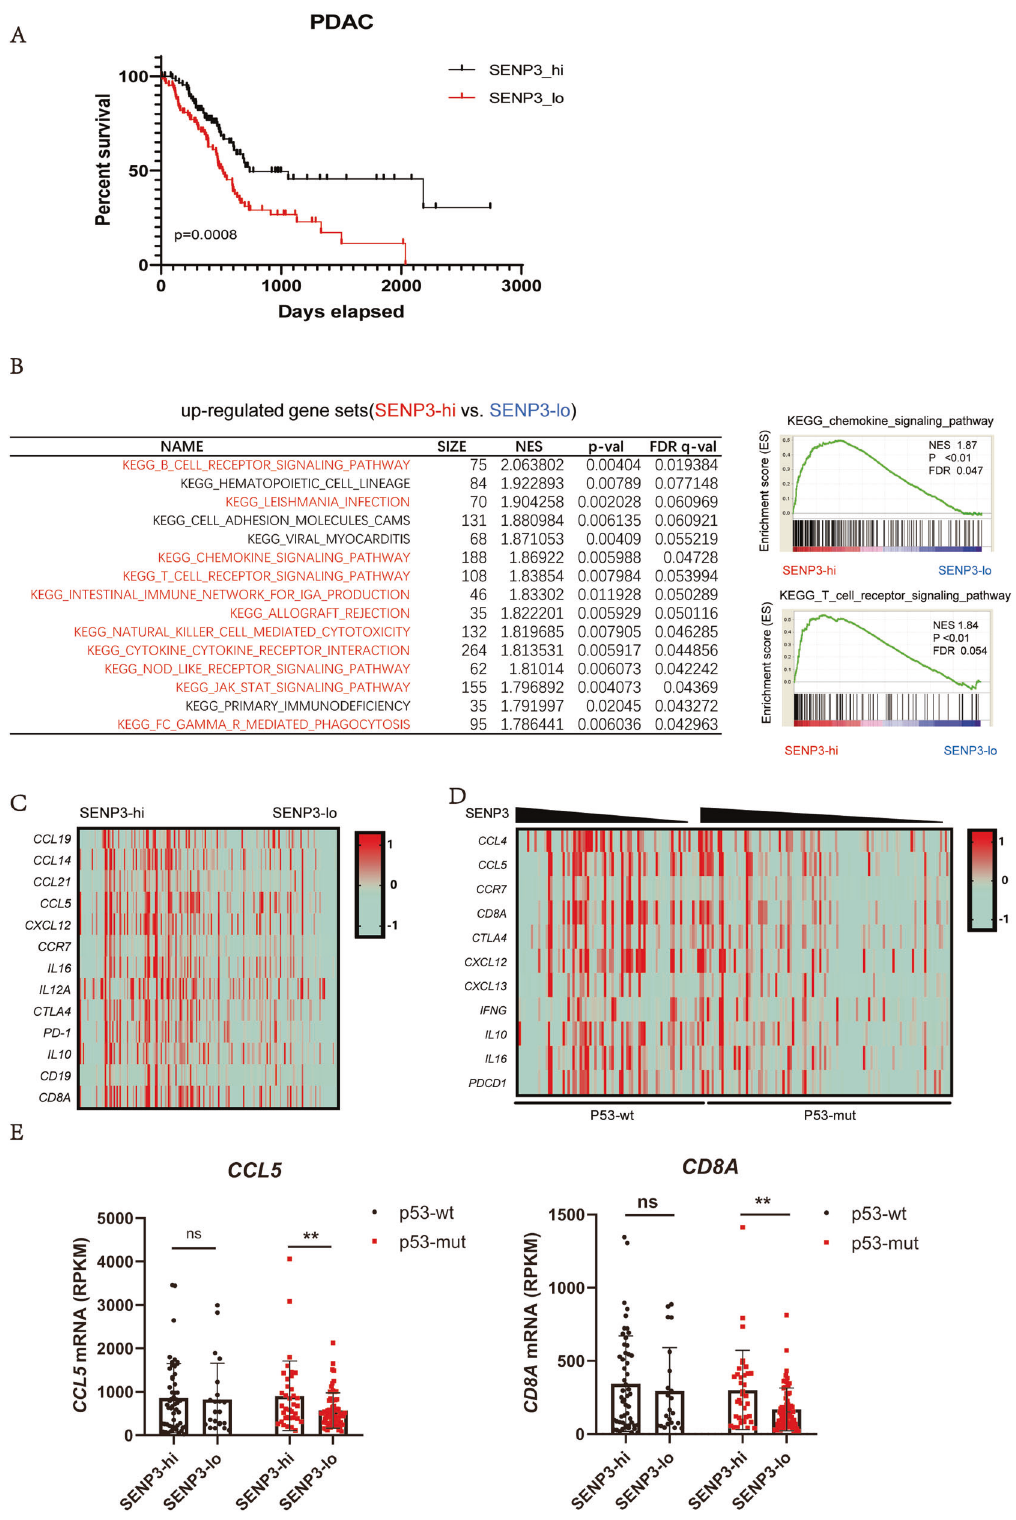
Fig. 5 SENP3 expression positively correlated with immune response in p53 mutant pancreatic cancer patients [40]. A Kaplan – Meier curves of human PDAC patients with SENP3 high or low. B Gene Sets Enrichment Assay (GSEA) is used to analyze RNA sequence data of PDAC patients from TCGA database. The list shows the top pathways upregulated in SENP3 high vs. SENP3 low and shows that chemokine signaling and TCR signaling-related genes were enriched in SENP3 high patients. C Heatmaps show that immune response-related genes are positively related to SENP3 expression level in PDAC patients from TCGA database. D Heatmaps show that immune response-related genes are a positive correlation with SENP3 expression levels in p53 mutant PDAC patients from TCGA database. E The high mRNA level of CCL5 and CD8A is shown in SENP3 high PDAC patients with p53 mutant but not the patients with p53 wild type.